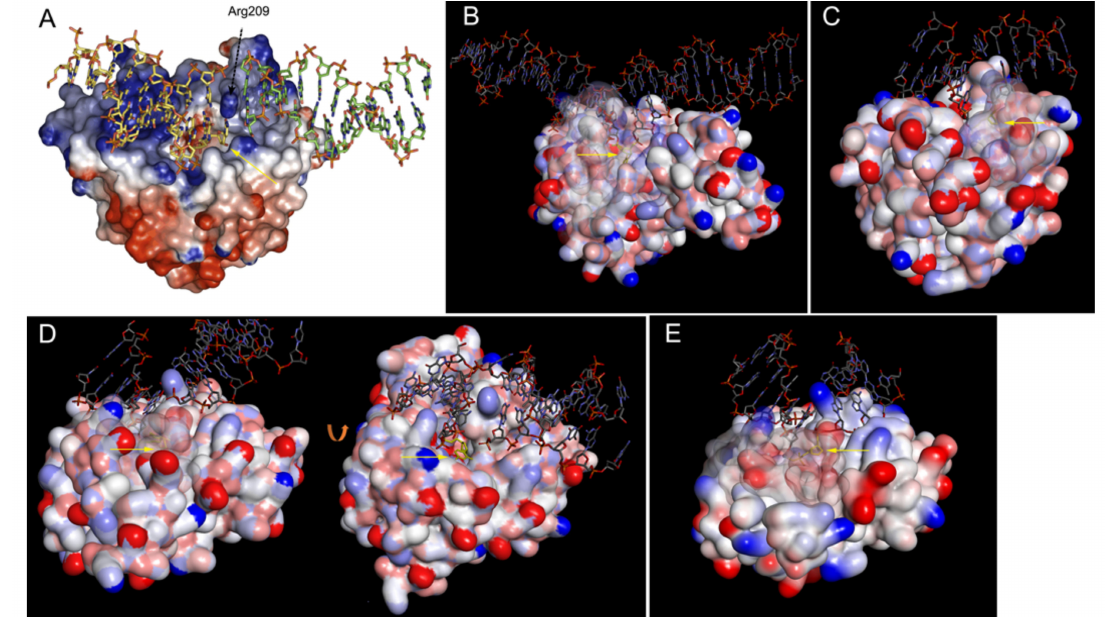
Figure 4. Nucleotide flipping out of DNA helix is the conserved DNA base damage recognition mechanism among NIR AP endonucleases. ( A ) Enzyme–substrate complex of the Mth212 D151N mutant obtained with dsDNA (exonuclease reaction substrate with a terminal dC in the active site) (PDB: 3GA6) [162]. ( B ) PfuEndoQ complex with a 27 mer duplex substrate with dU at the active site (PDB: 7K30) [167]. ( C ) Human APE1 bound to non-cleaved THF-DNA (PDB: 1DE8) [141]. ( D ) E. coli Nfo H69A mutant bound to a cleaved DNA duplex containing α dA (PDB: 4K1G) [168]. ( E ) E. coli Nfo Y72A mutant bound to THF-DNA (PDB: 2NQ9) [169]. Yellow arrows point to the nucleotides flipped into the active